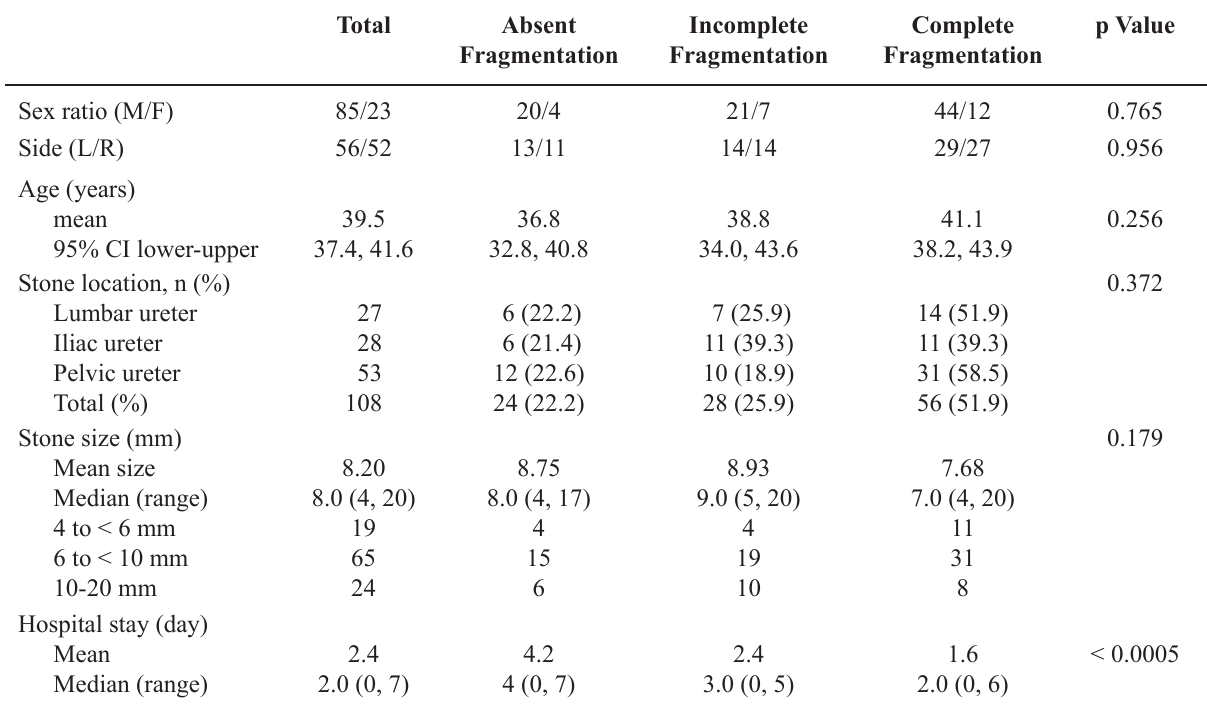
Table 1 – Patients characteristics and relation to first ESWL